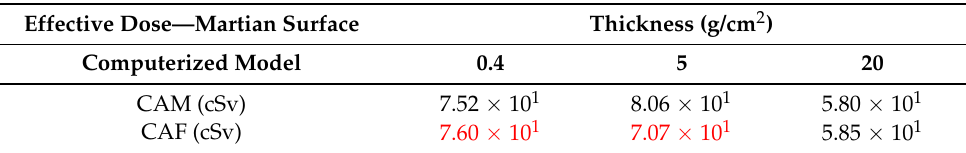
Table 7. Effective doses from 993/4 SPE for CAM and CAF on the surface of Mars behind various thicknesses of aluminum shielding. NASA’s permissible effective dose limits for 1-year mission and 88 cSv for 40-year old males and 70 cSv for 40-year old females [14]. Effective Dose—Martian